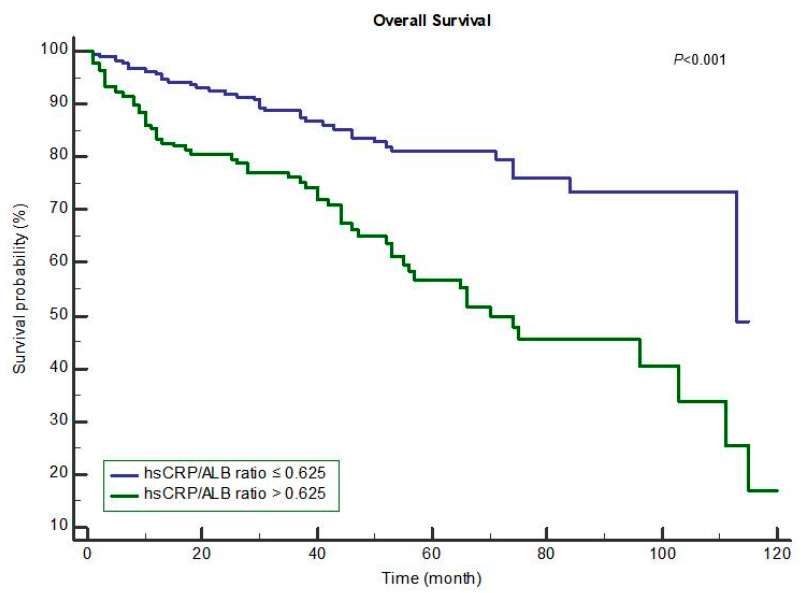
Figure 1. Overall survival after resection for hepatocellular carcinoma. Mean overall survival time ≤ 0.625: 95.10 months vs. >0.625: 70.94 months, p < 0.001.